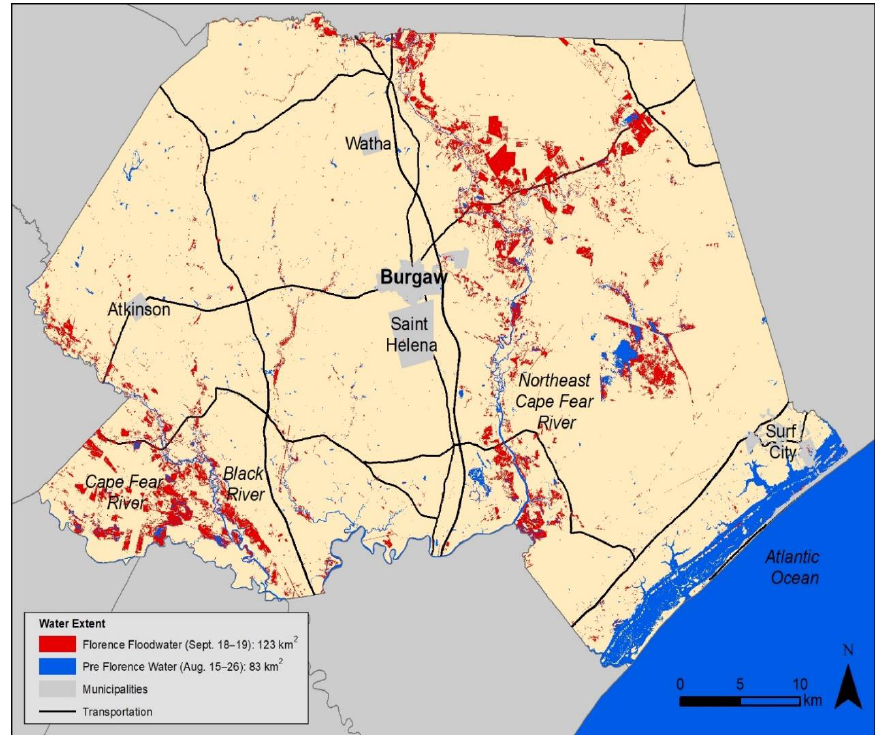
Figure 4. Hurricane Florence (September 14, 2018) flood inundation. (Data sources: NC Department of Transportation (roads and municipalities) and PlanetScope imagery).